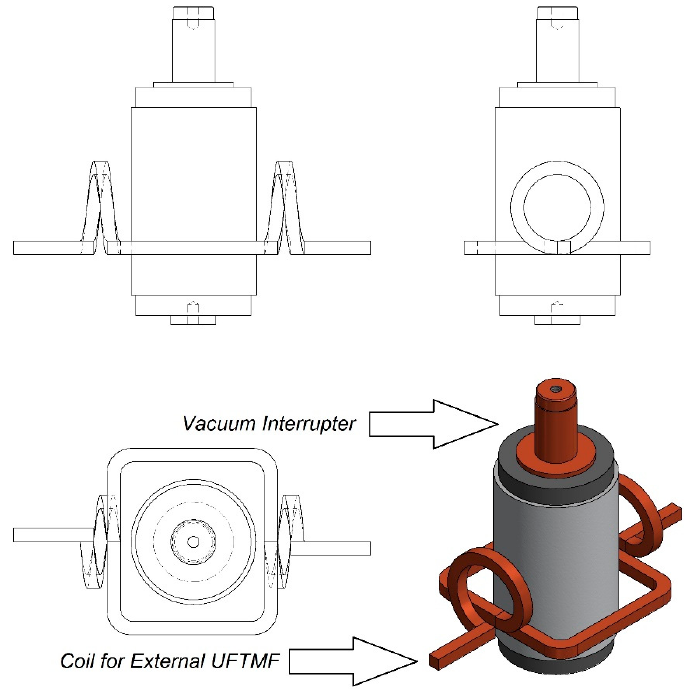
Figure 7. A vacuum interrupter (VI) equipped with an external UFTMF coil.